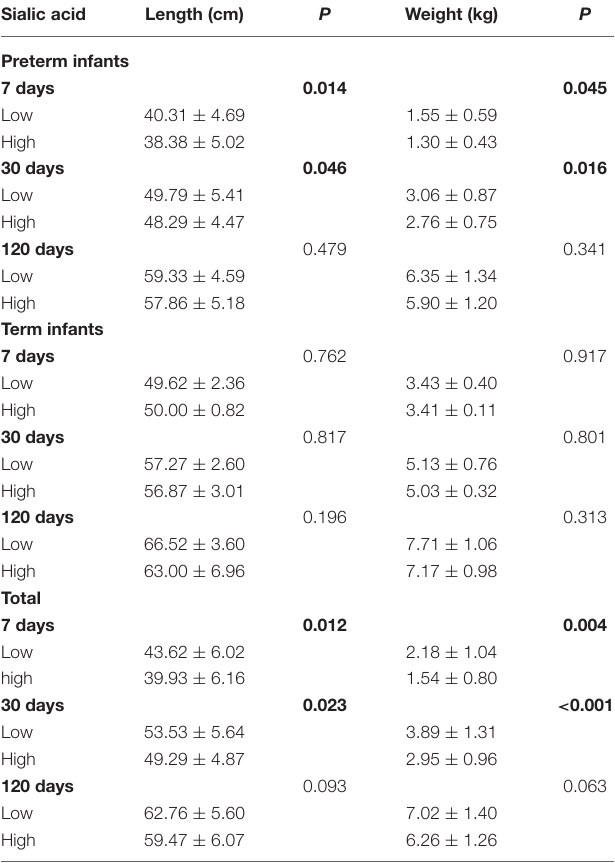
TABLE 4 | Effects of different levels of sialic acids on the growth and development of infants. Sialic acid Preterm